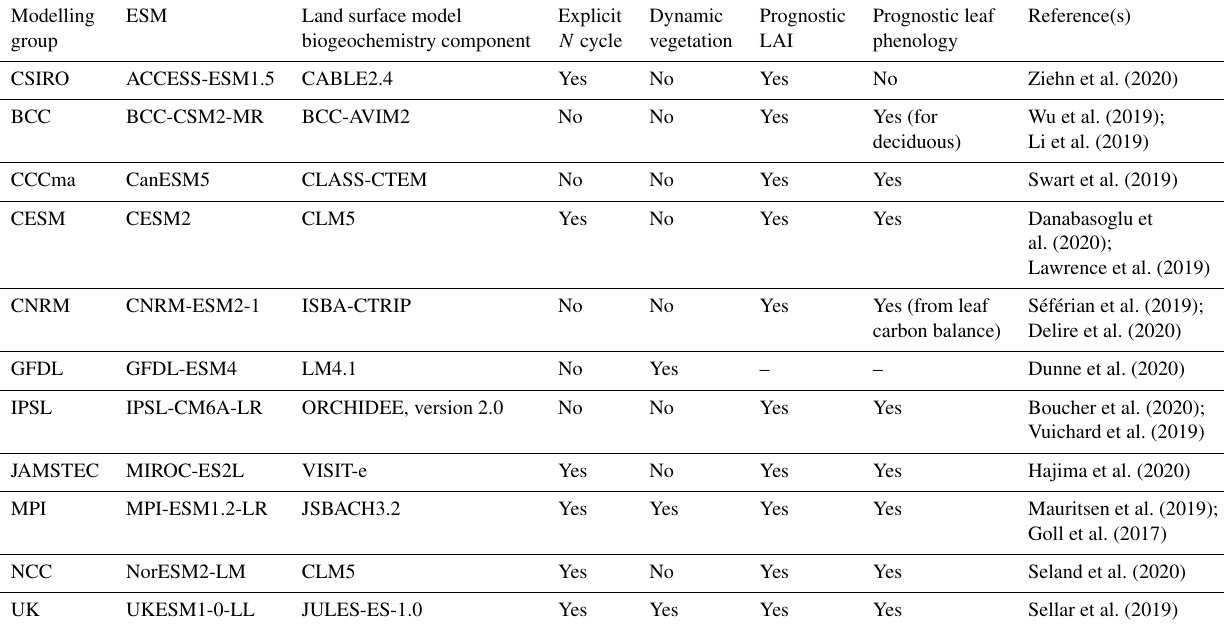
Table 1. Modelling group contributions to C 4 MIP of CMIP6 from Arora et al. (2020). Modelling